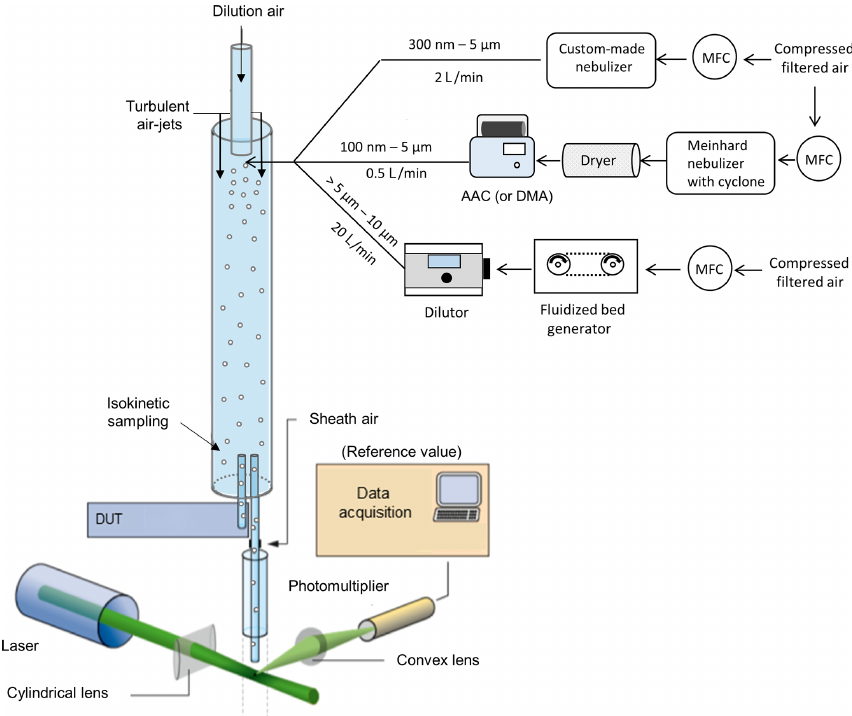
Figure 1. Schematic illustration (simplified) of the primary standard at METAS. MFC, DMA, and AAC stand for mass flow controller, differential mobility analyser, and aerodynamic aerosol classifier, respectively. For a more detailed description of the experimental set-up and the isokinetic sampling probes, readers are referred to Horender et al. (2019) and Vasilatou et al.